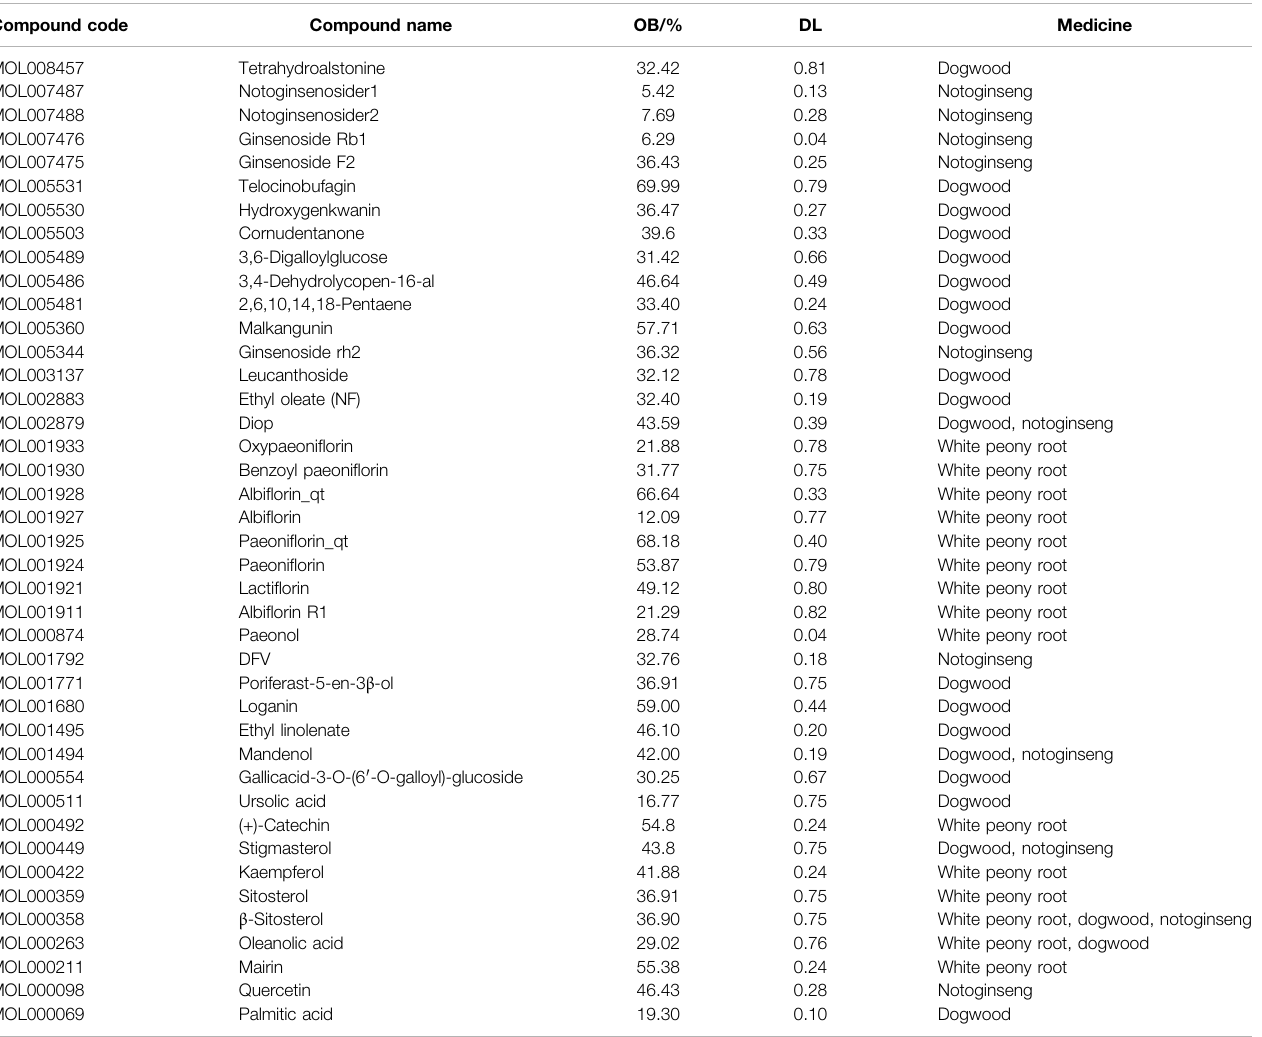
TABLE 1 | Basic information of PNM